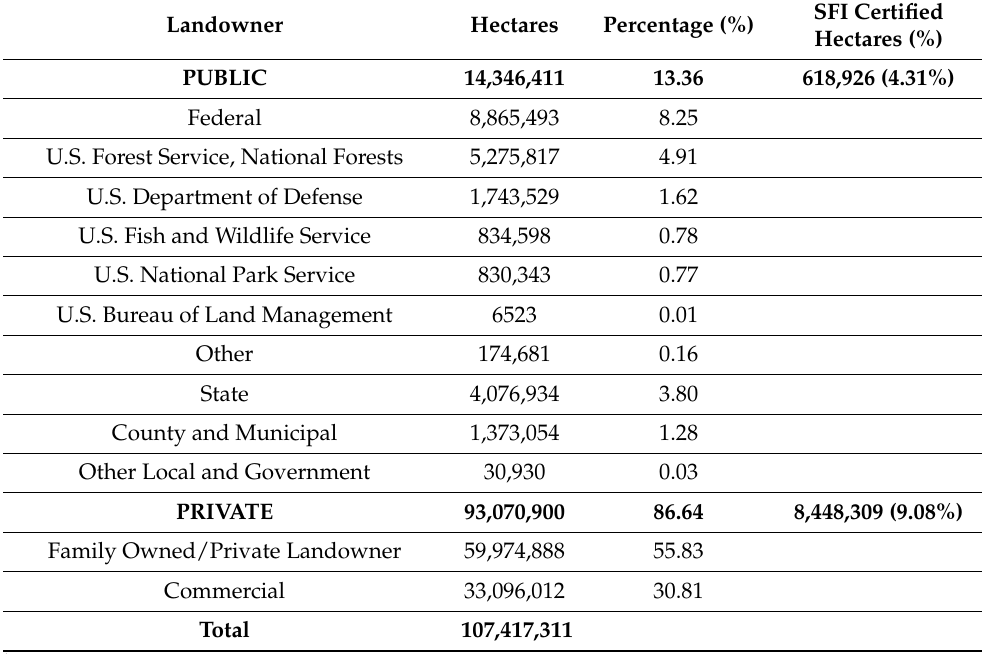
Table 1. Hectares of public and private forestlands within the 13 southeastern states, the percentage (%) of forestlands designated to each category, and the known hectares certified to the Sustainable Forestry Initiative (SFI) with the percentage of certified public and private forestlands. Data were obtained from the United States Department of Agriculture Forest Service Forest Inventory and Analysis Program 1